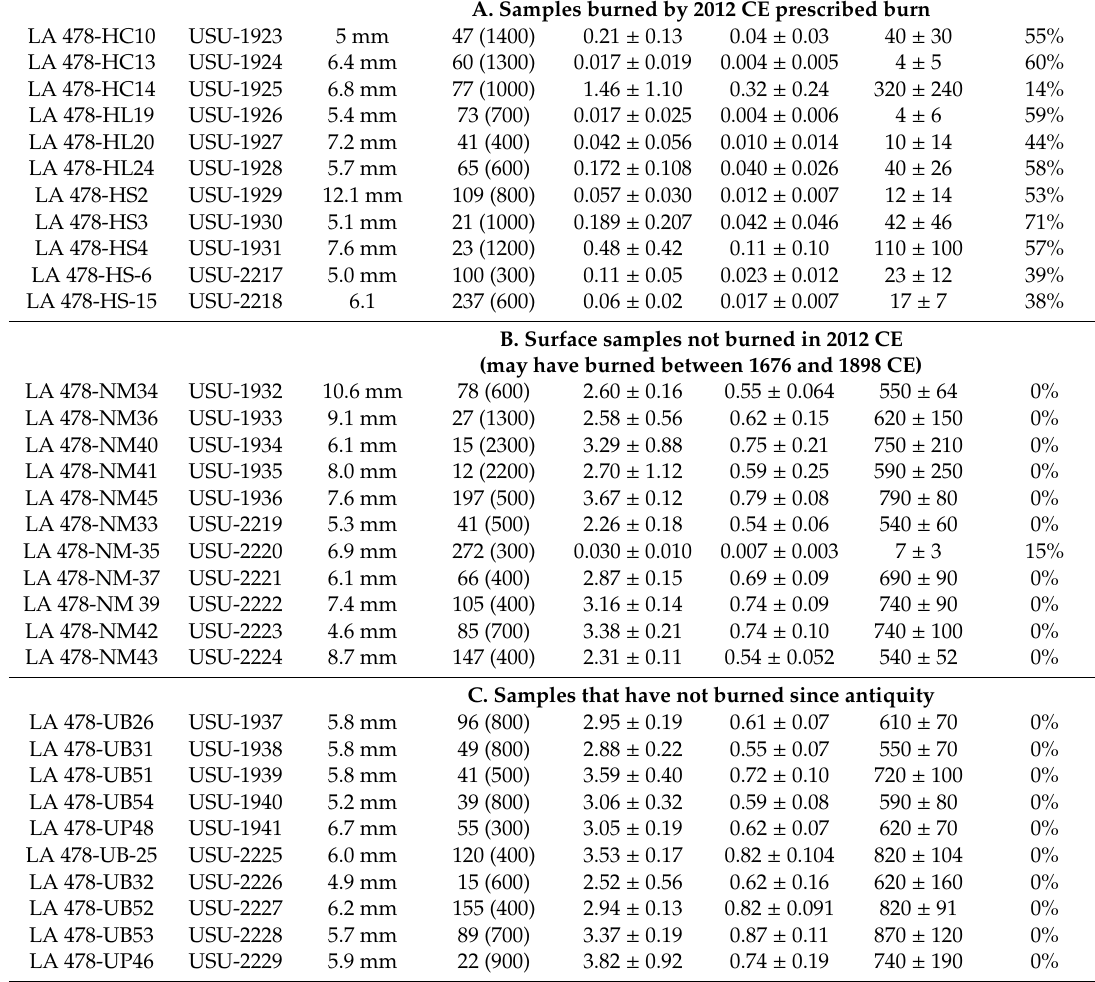
Table A2. Age results from single-grain optically stimulated luminescence (SG-OSL) dating of quartz sand temper from the sherds. Sample Num.